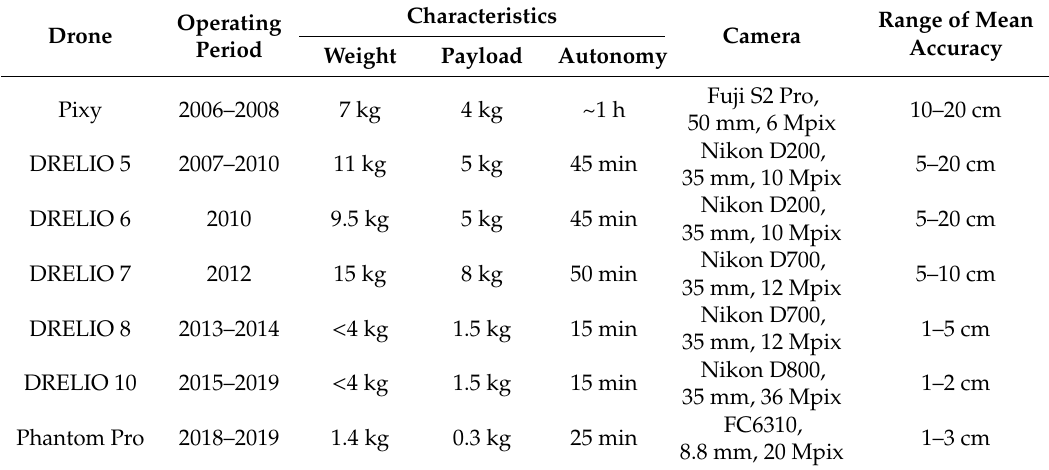
Table 1. Main characteristics of the di ff erent UAV platforms used for Porsmilin Beach monitoring.